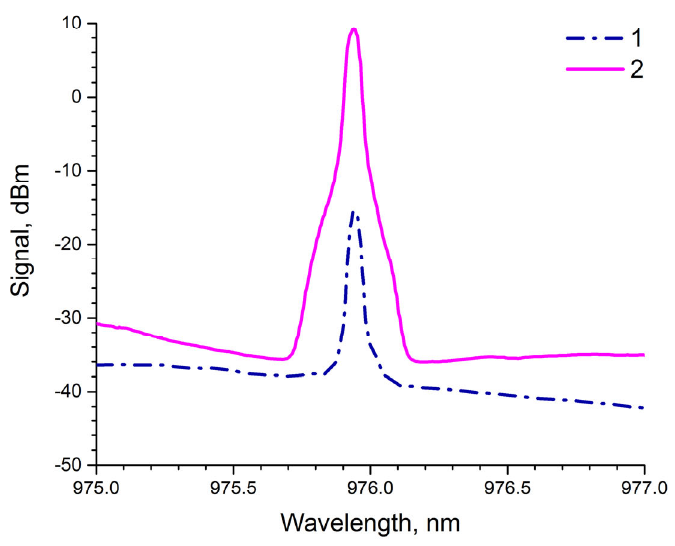
Figure 2. The emission spectrum of a “random” laser at different values of the pump power: “1”—30 mW; “2”—70 mW.